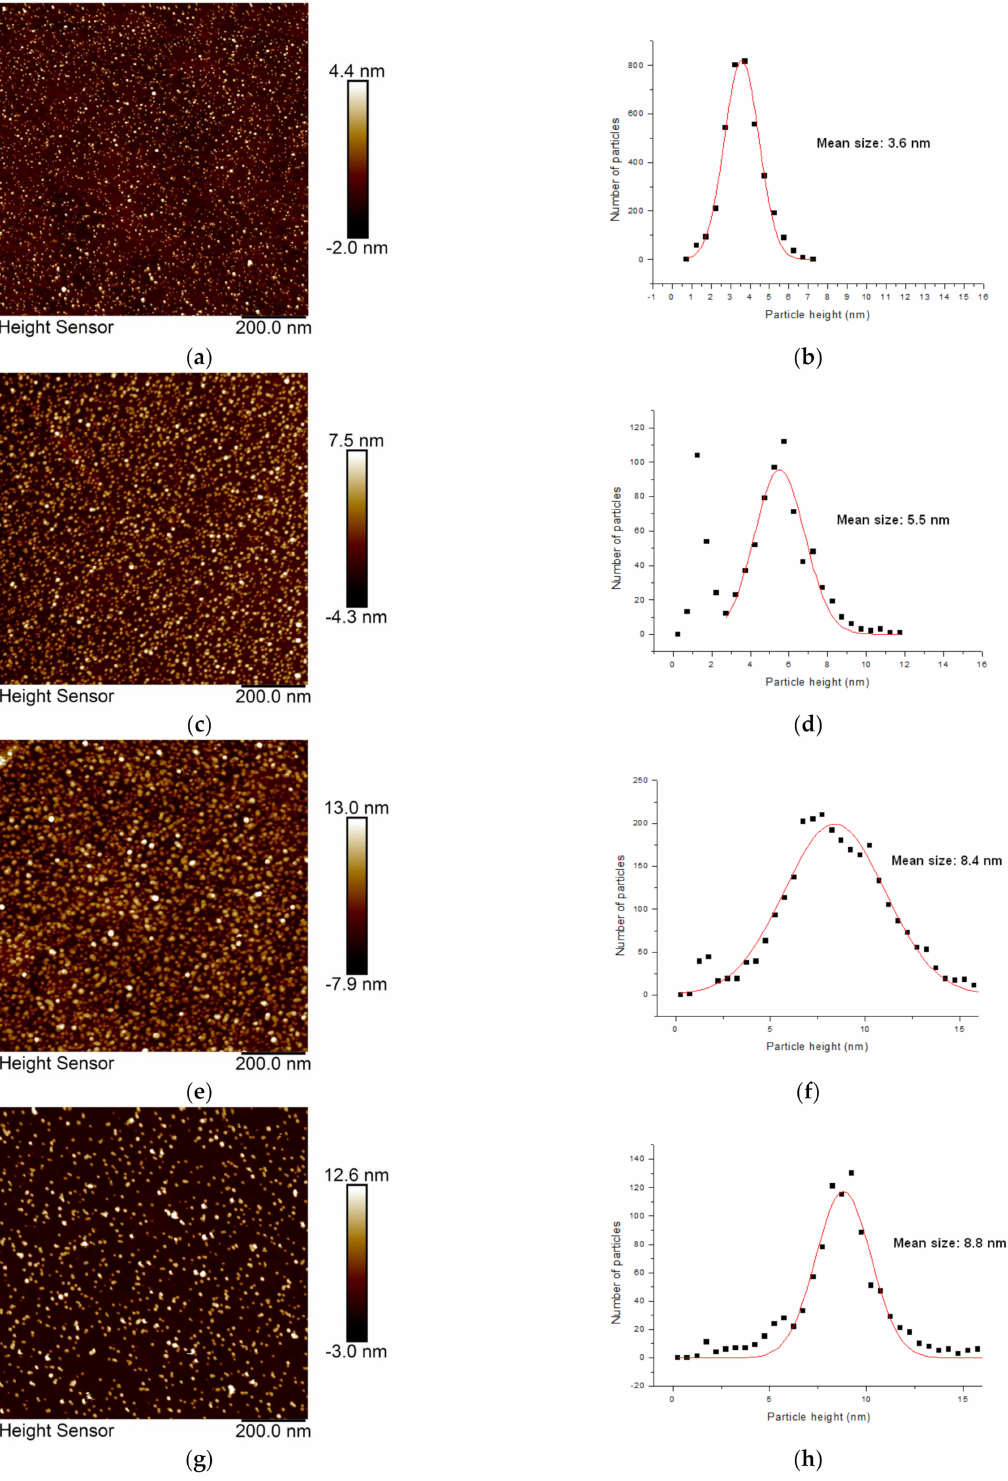
Figure 2. AFM images of Ag NPs deposited for various target–orifice distances: ( a ) 50 mm, ( c ) 80 mm, ( e ) 150 mm, and ( g ) 200 mm. The graphs show the size (height) distributions of the Ag NPs for the corresponding AFM images: ( b ), ( d ), ( f ), and ( h ),